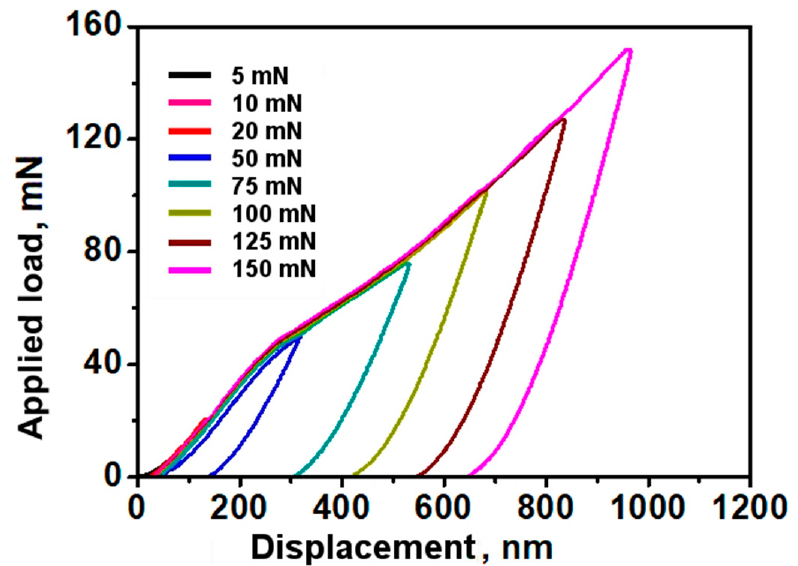
Figure 7. Load–displacement curves of indentations made on the TiN film.